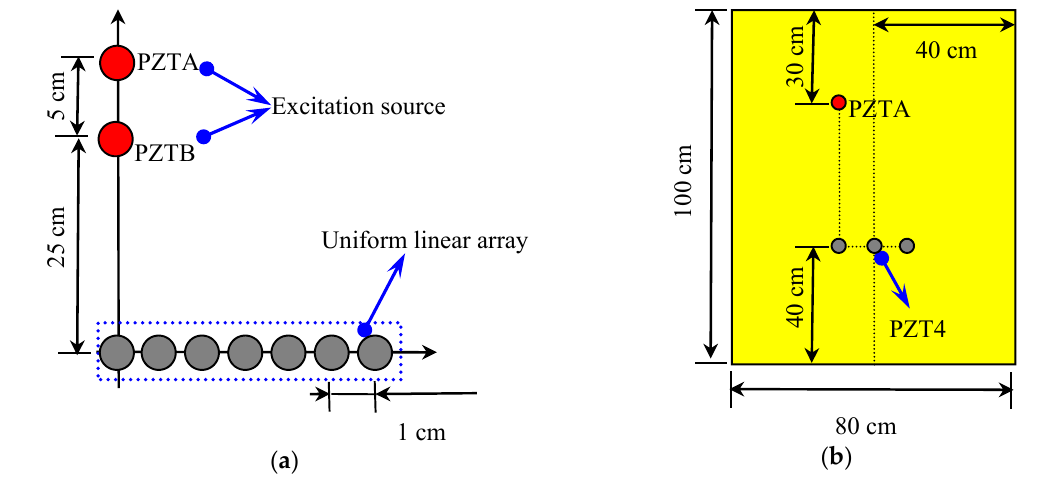
Figure 2. Deformation experiment: ( a ) sensor arrangement; ( b ) plate sensors.